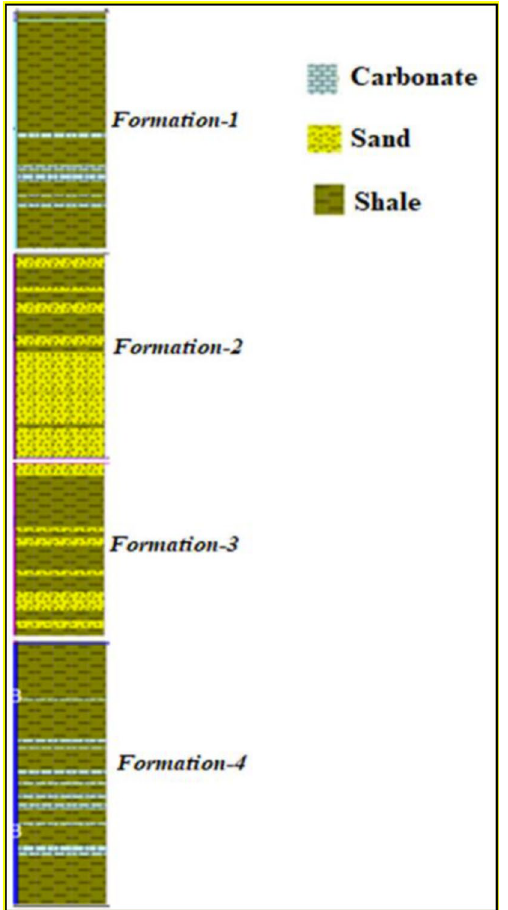
Figure 2. Lithology column for Well-1.